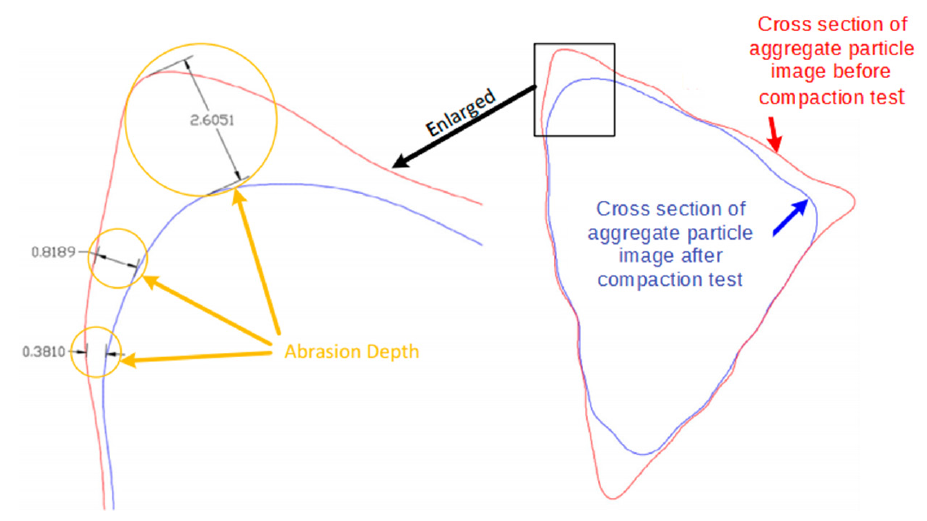
Figure 20. Illustration of abrasion depth calculation.